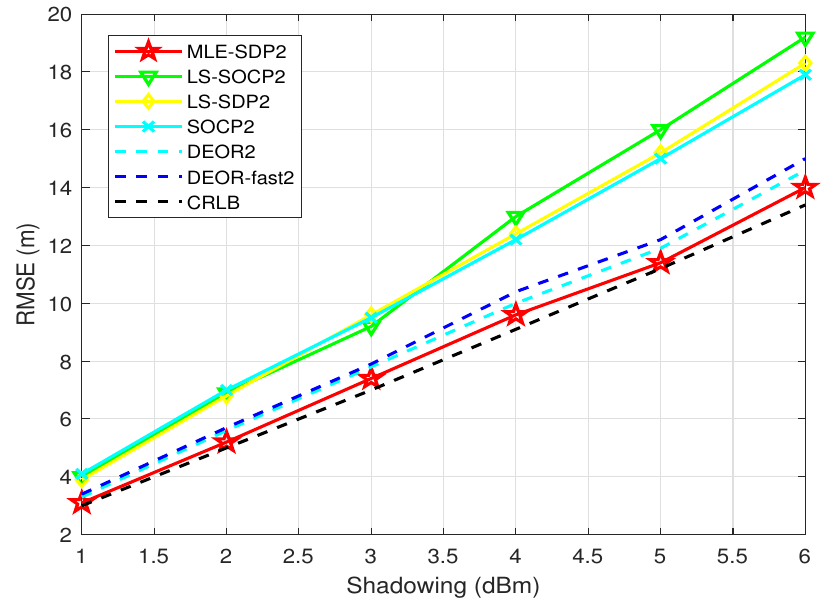
Figure 5. When L 0 is unknown, this is the relationship between RMSE and σ n